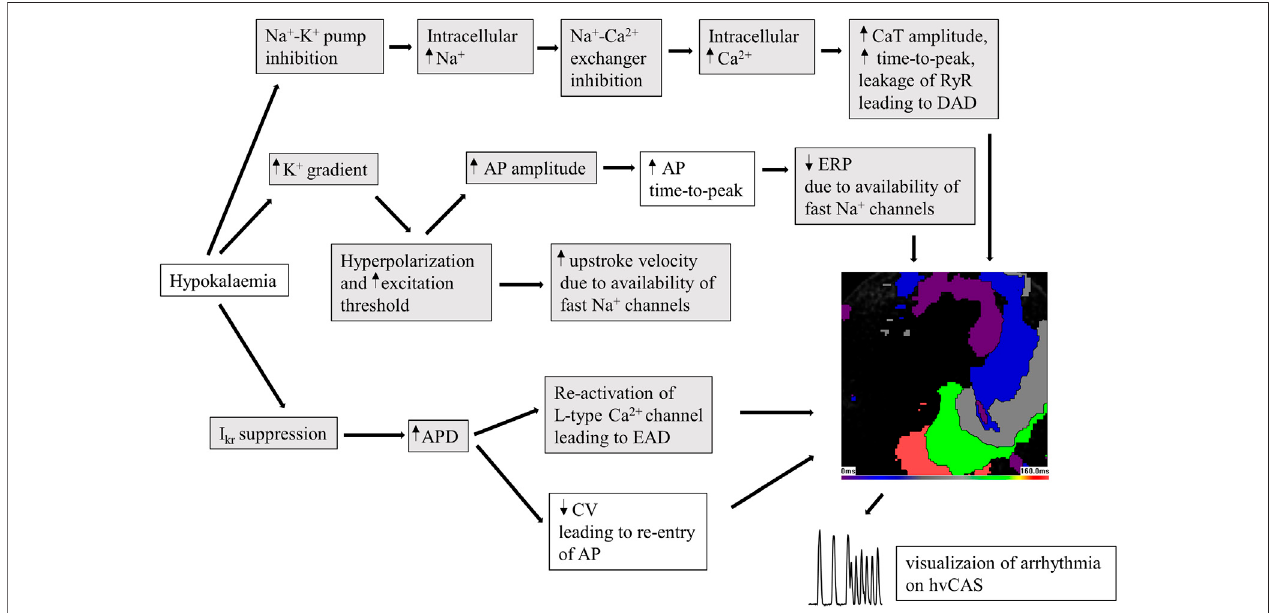
FIGURE 6 | Diagram showing the changes caused by hypokalaemia in human pluripotent stem cell-derived human ventricular cardiac anisotropic sheet (hvCAS) during acute hypokalaemic (hypoK) experiment where the treatment was for 15 min before data acquisition. Hypokalaemia refers to 3 mM KCl in Tyrode solution on the samples. Those changes make cardiomyocytes prone to arrhythmia in hypokalaemic conditions. The boxes highlighted in grey are adapted from literature research. Those changes leading to arrhythmia can be visualized on the hvCAS.